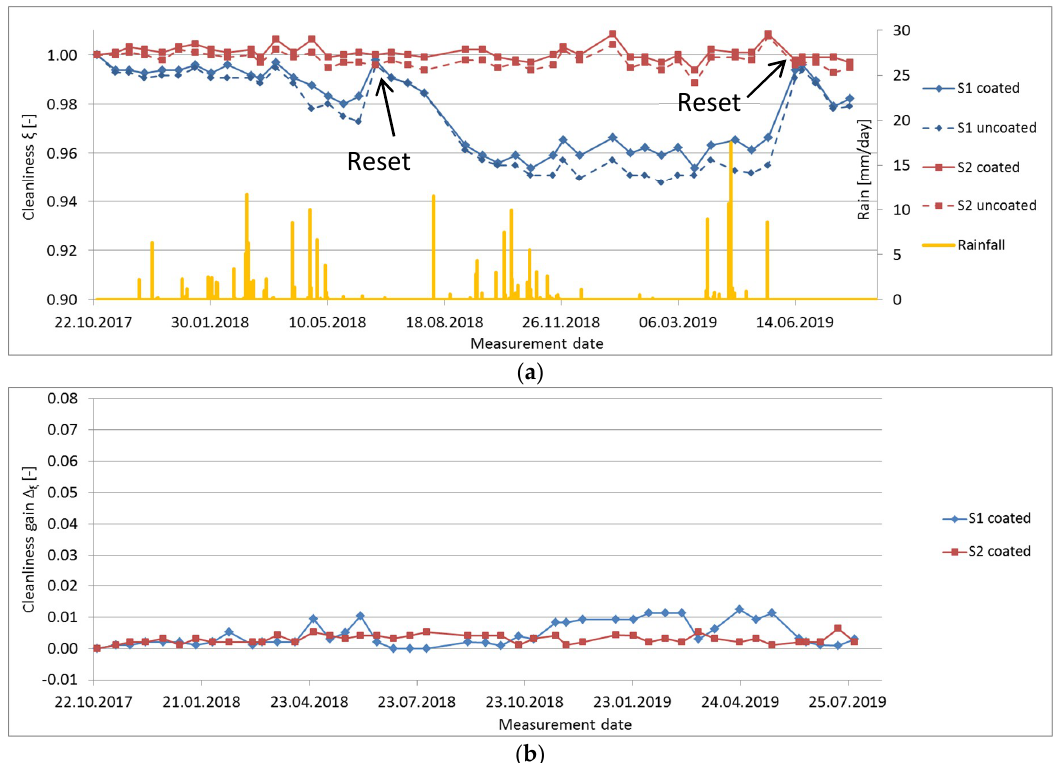
Figure 4. Data after cleaning, ( a ): cleanliness factor, ( b ): cleanliness gain.